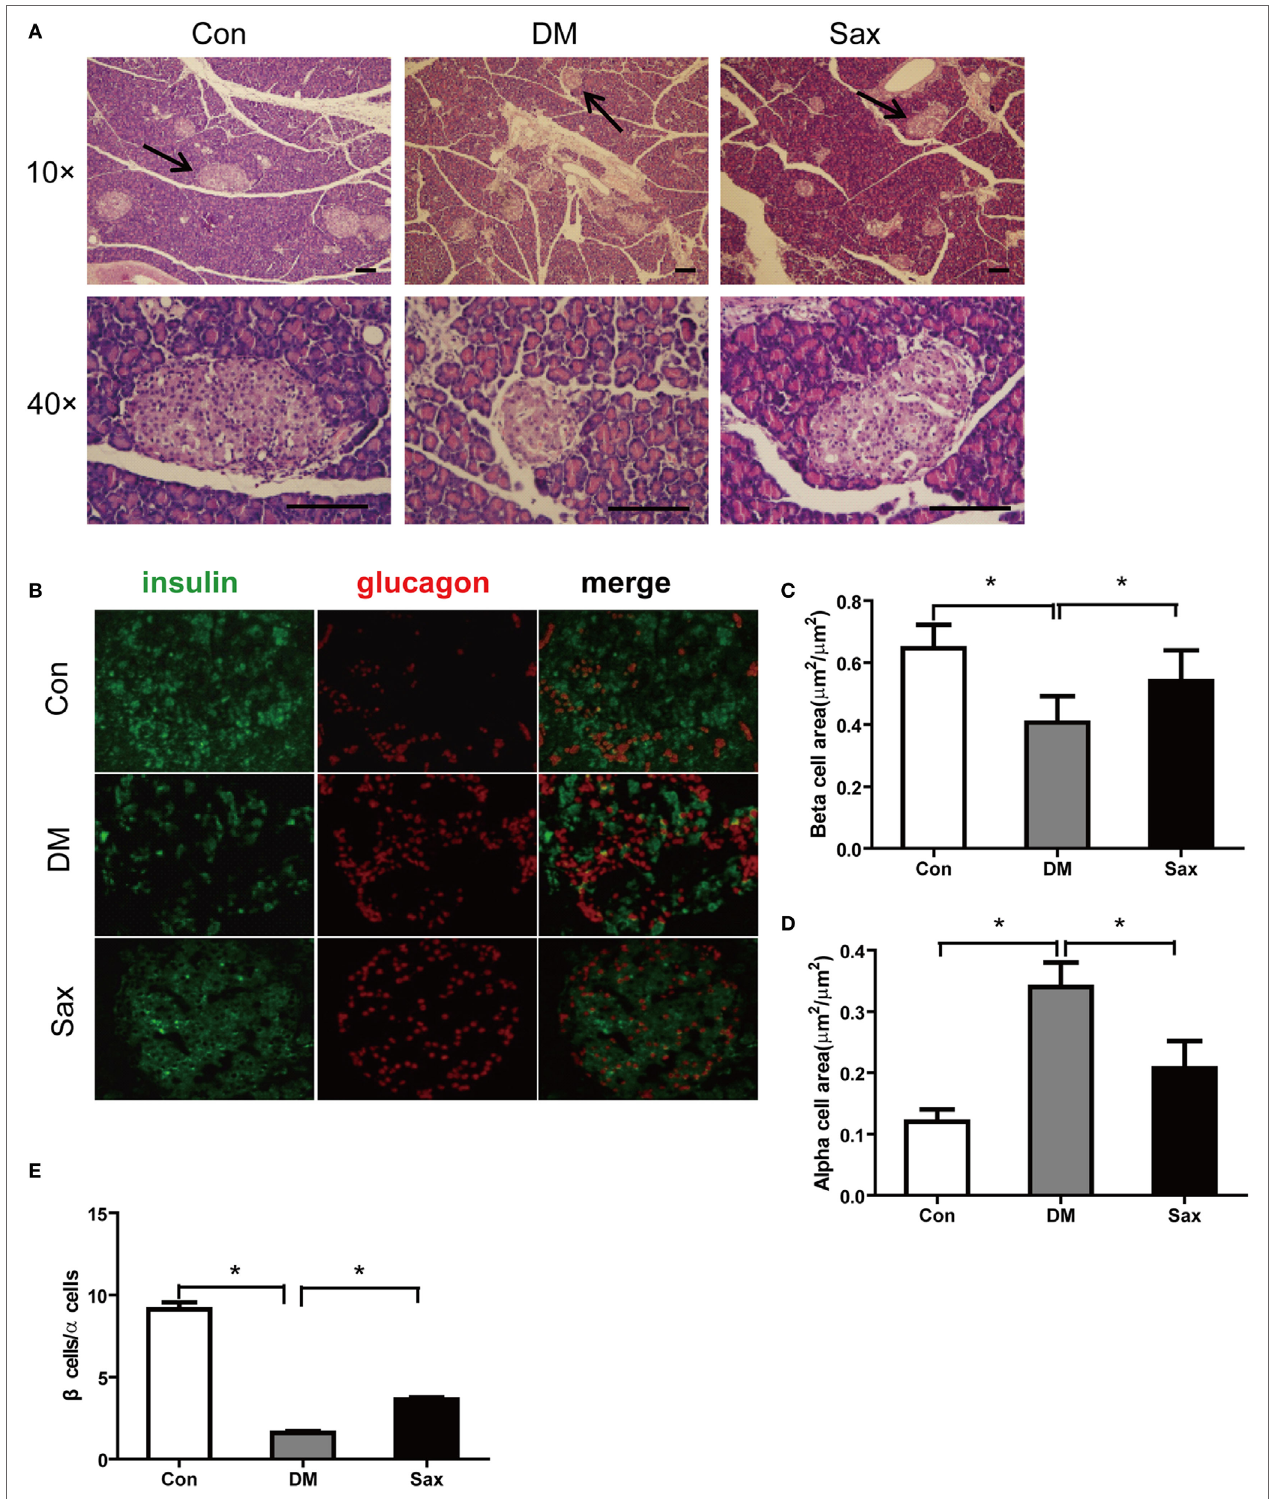
FigUre 2 | Effects of saxagliptin on islet morphology. Representative pancreas sections were stained with hematoxylin and eosin (a) or labeled with anti-insulin antibody (green) or anti-glucagon antibody (red) (b) . The graphs on the right represent the average percentage of insulin-positive area (c) . Glucagon-positive cell area (D) . β -cells to α -cells number ratio (e) . n = 4 for each group. Data were reported as mean ± SEM. Con, control; DM, diabetes; Sax, saxgliptin. * p < 0.05 compared with the control group and Sax group.